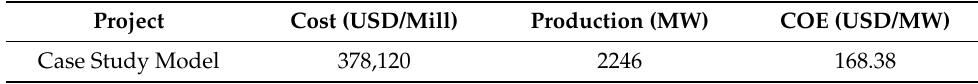
Table 6. A summary of cost outputs for the